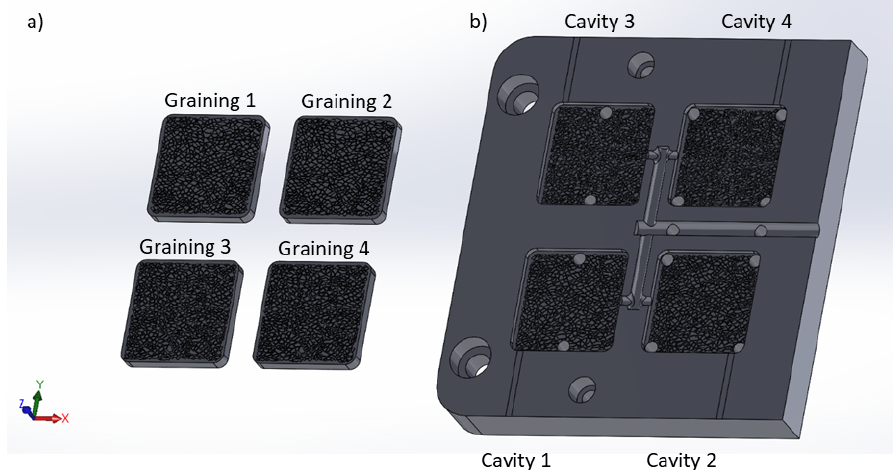
Figure 1. ( a ) Designed parts with grain structure, ( b ) Designed mold of the ejector